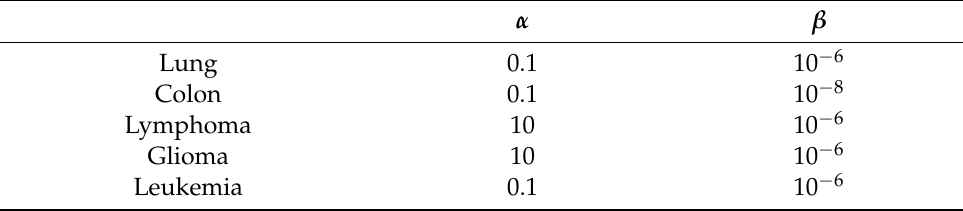
Table 2. The regularization parameters of